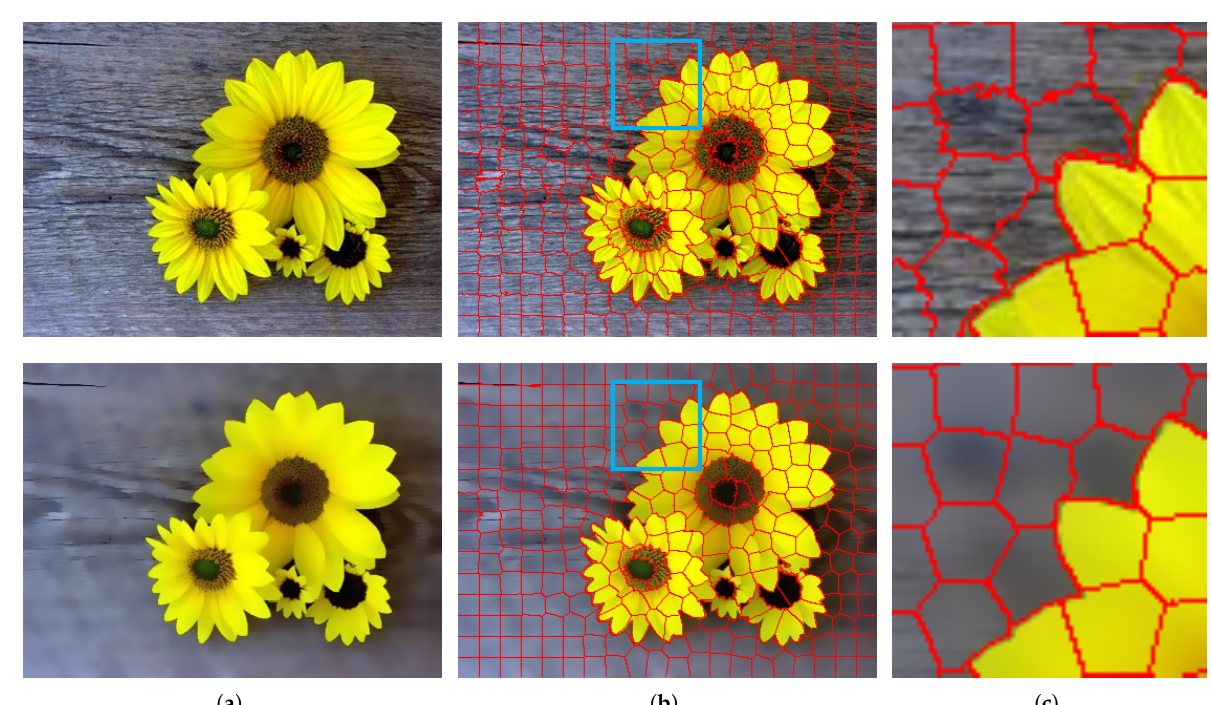
Figure 1. Comparison of the SLIC superpixel result between original and bilateral filtered images. The upper row illustrates the original image, and the lower row illustrates the bilateral filtered image. ( a ) Input RGB images; ( b ) SLIC superpixel results; ( c ) enlarged image of the part indicated by the blue box in ( b